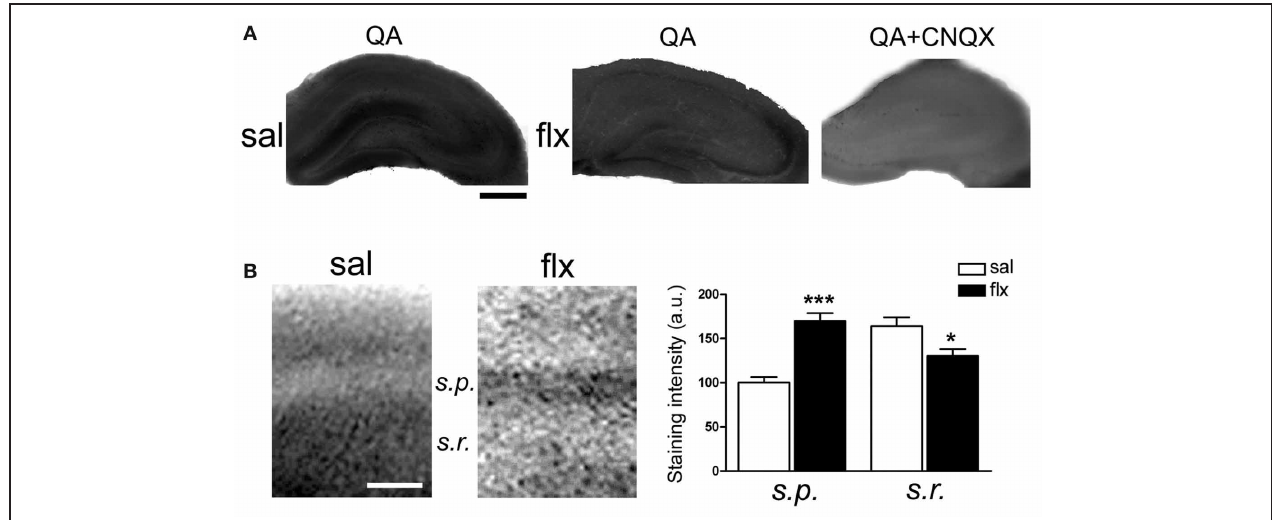
FIGURE 6 | Long-term fluoxetine administration decreased Ca 2 + -permeable AMPA-Rs in the CA1 stratum radiatum (s.r.) . Hippocampal slices from saline- (sal) and fluoxetine- (flx) treated rats were stimulated with 100 μ M quisqualic acid (QA) to detect Co 2 + uptake. The AMPA-R blocker CNQX (20 μ M) was used as a negative control (QA + CNQX). (A) Hippocampal sections are shown